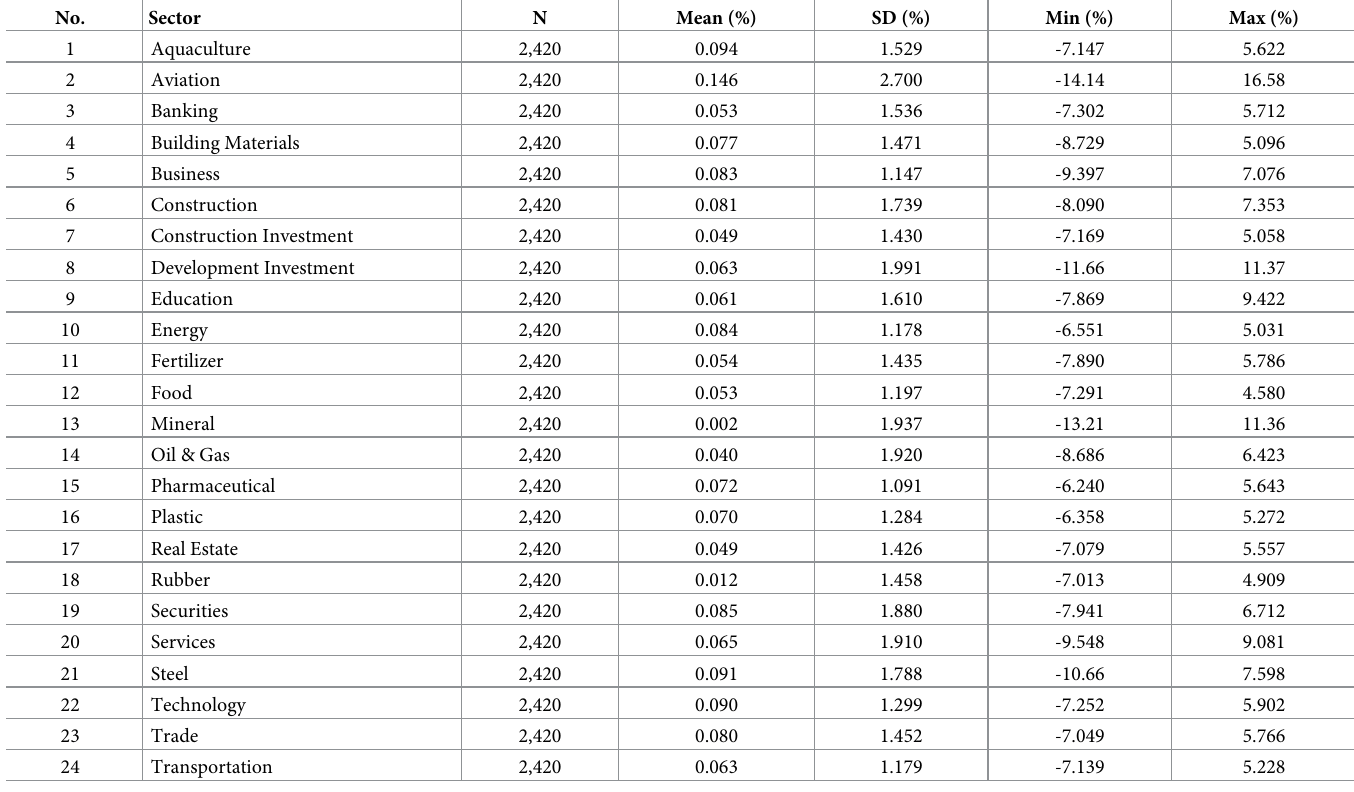
Table 2. Descriptive statistics of the daily return of 24 sectors in